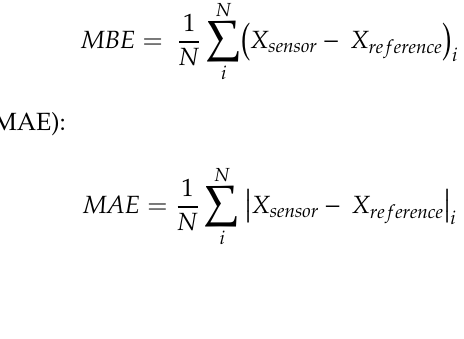
Figure S1: Typical sensor package setup, S2: (a) Scatter plot of CF = atm to CF = 1 PM 2.5 concentrations and (b) ratio of the CF = atm to CF = 1 vs. PM 2.5 concentrations vs. PM 2.5 CF = 1 concentration at the Natchez fire, S3: Overlaid scatter plot of smoke impacted datasets with the linear fit smoke calibration and the resulting MAE and NRMSE for the calibration adjusted data for (a) AQY (b) PA and (c) RAMP. Table S1: Selected sensor manufacturers, models, and measured parameters, Table S2: Reference mean ( µ ), standard deviation ( σ ), minimum value (min), and maximum value (max) for fine particulate matter (PM 2.5 ) concentrations and temperature (T) and relative humidity (RH) at each deployment location, Table S3: Linear regression parameters for sensor correction and adjusted R 2 developed from AIRS ambient